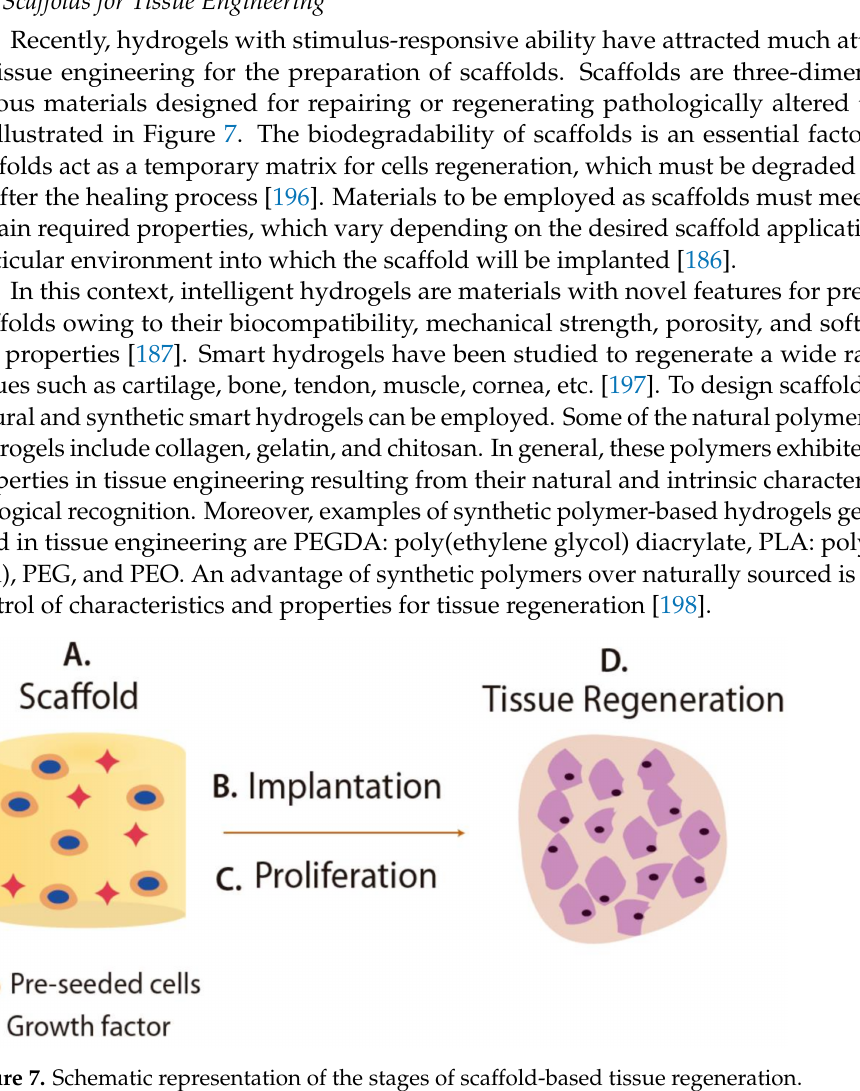
Figure 7. Schematic representation of the stages of scaffold-based tissue